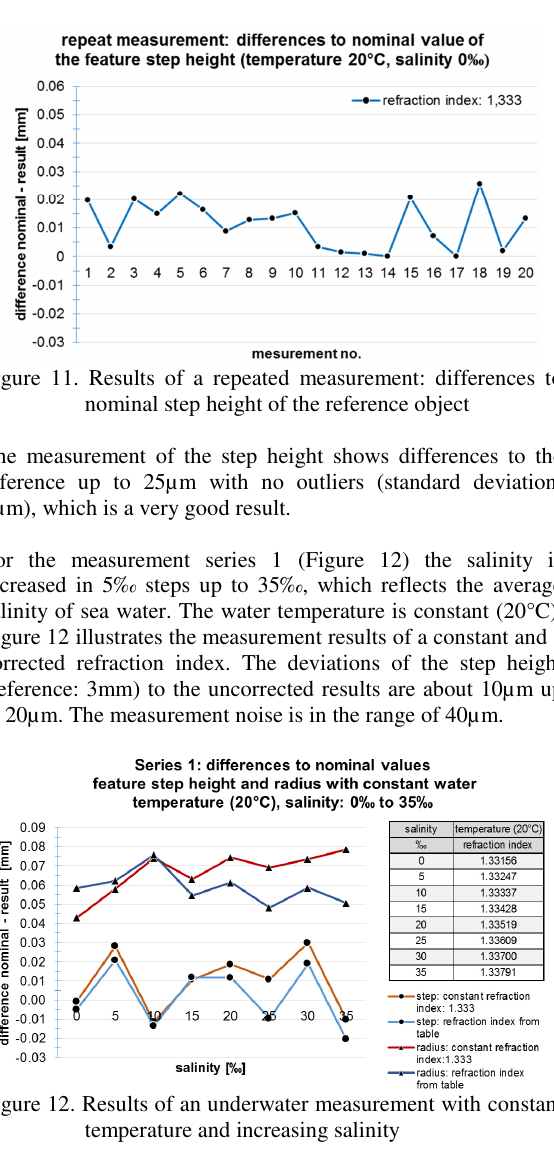
(Figure 13). The systematic deviations of circle measurement